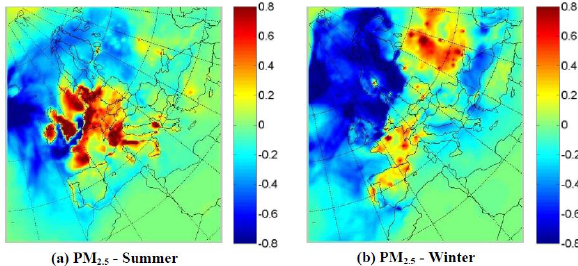
Fig. 11. Predicted reduction (base case – increased temperature sce- nario) in ground-level (µgm − 3 ) concentrations of total PM 2 . 5 after Figure 11. Predicted reduction (base case - increased temperature scenario) in ground-level 3 a 5 K increase of temperature during (a) the modeled summer period (μg m -3 ) concentrations of total PM 2.5 after a 5 K increase of temperature during (a) the 4 and (b) the modeled winter period. A positive value corresponds to modeled summer period and (b) the modeled winter period. A positive value corresponds to a 5 a decrease. 6